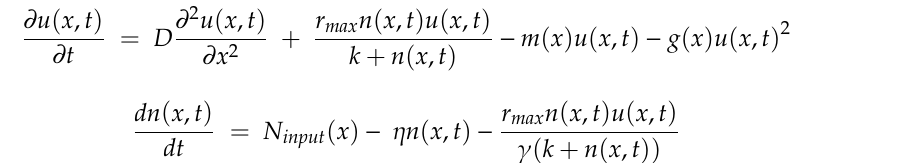
Figure 2. Size of ENERGY TRAPA heterogeneous , dif fusion (dotted) and Figure 2. Size of 𝐸𝑁𝐸𝑅𝐺𝑌 𝑇𝑅𝐴𝑃𝐴 (cid:3035)(cid:3032)(cid:3047)(cid:3032)(cid:3045)(cid:3042)(cid:3034)(cid:3032)(cid:3041)(cid:3032)(cid:3042)(cid:3048)(cid:3046),(cid:3031)(cid:3036)(cid:3033)(cid:3033)(cid:3048)(cid:3046)(cid:3036)(cid:3042)(cid:3041) (dotted) and TRAPAENERGY , (solid) as ENERGY TRAPA heterogeneous , no dif fusion (dashed) and ENERGY TRAPA homogeneous , (solid) as function of 𝐸𝑁𝐸𝑅𝐺𝑌 𝑇𝑅𝐴𝑃𝐴 (cid:3035)(cid:3032)(cid:3047)(cid:3032)(cid:3045)(cid:3042)(cid:3034)(cid:3032)(cid:3041)(cid:3032)(cid:3042)(cid:3048)(cid:3046),(cid:3041)(cid:3042) (cid:3031)(cid:3036)(cid:3033)(cid:3033)(cid:3048)(cid:3046)(cid:3036)(cid:3042)(cid:3041) (dashed) and homogeneous r 1 . r 1 / K 1 > r 2 / K 2 holds after r 1 > 7. The parameter values are the same as in Figure function of r 1 . r 1 /K 1 > r 2 /K 2 holds after r 1 > 7. The parameter values are the same as in Figure 1 .